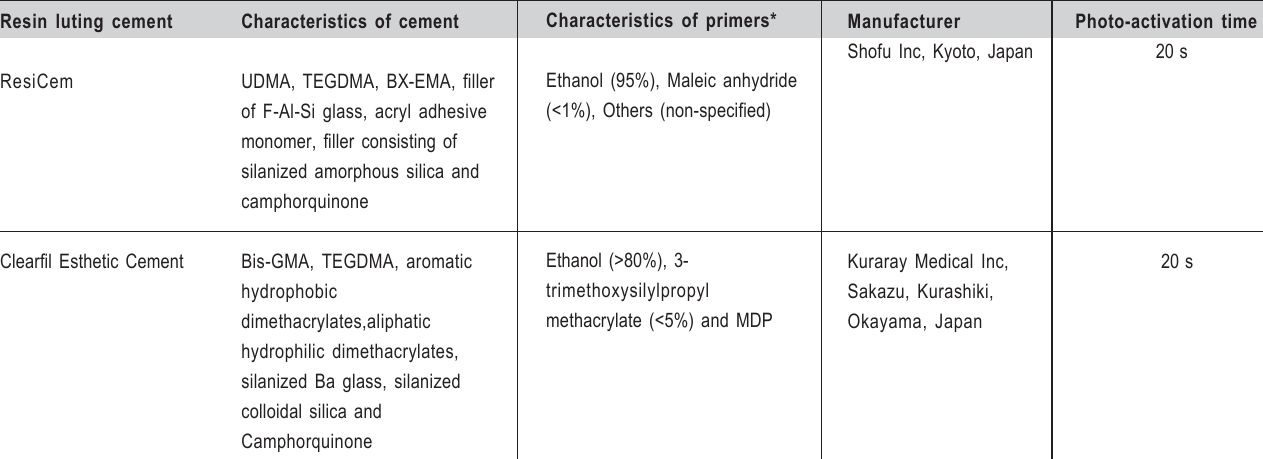
Table 1. Resin luting cements and respective